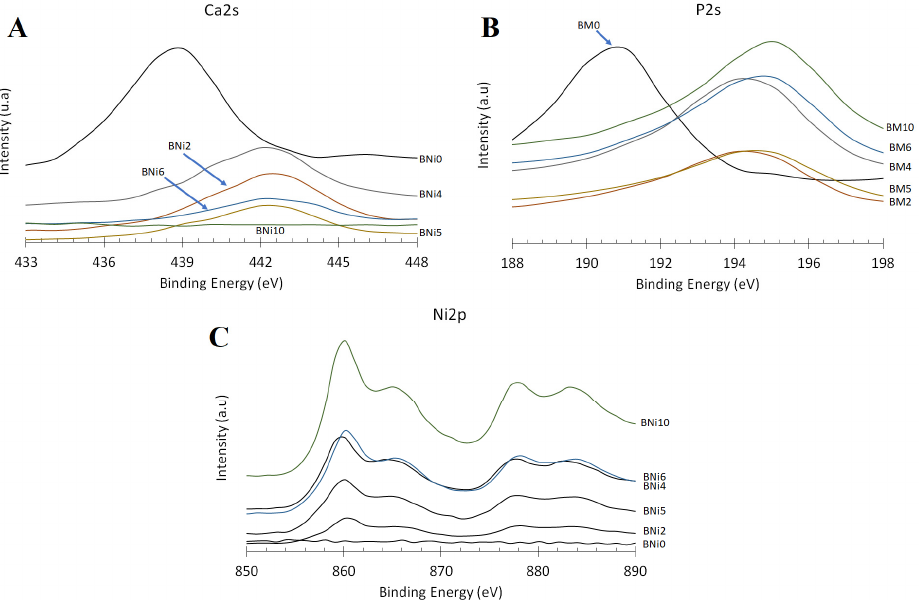
Figure 6. XPS analysis of the chemical state of ( A ) Ca 2s, ( B ) P 2s, and ( C ) Ni 2p orbitals in CaxNi1- x HPO 4 ·nH 2 O compounds.